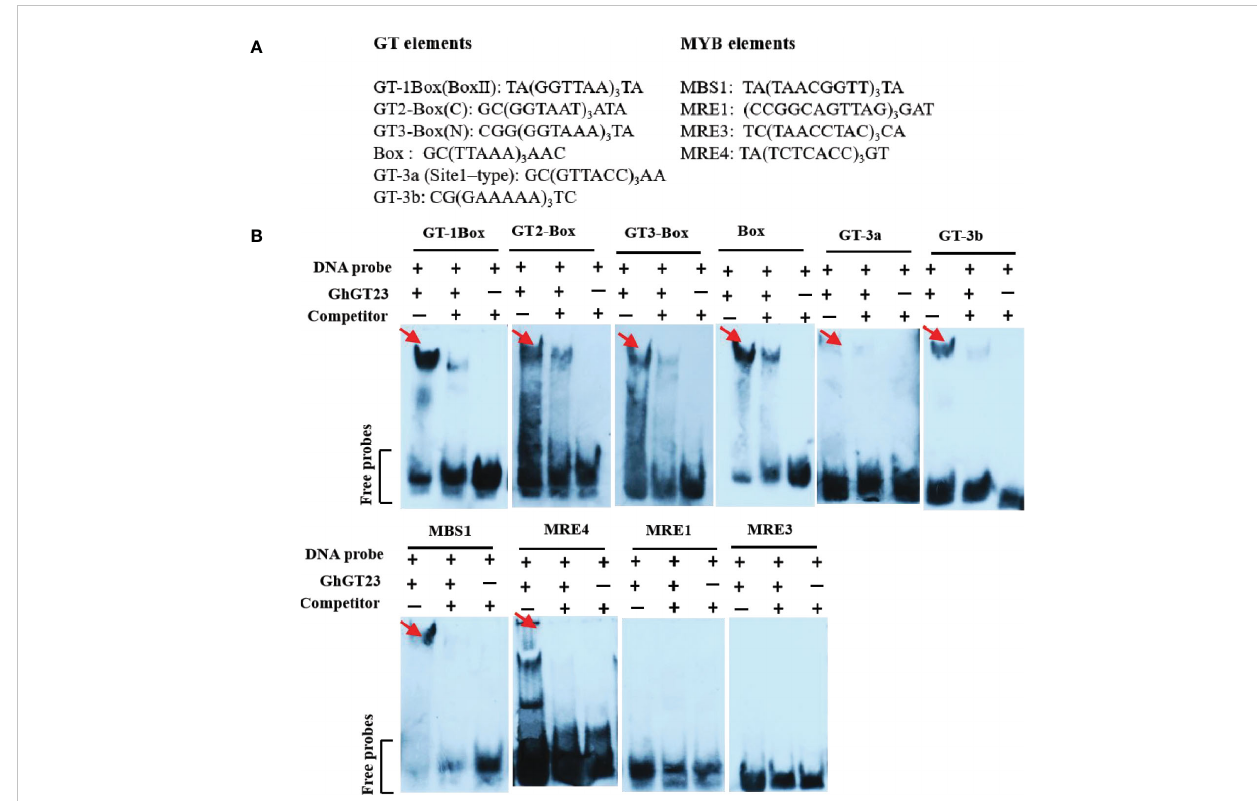
FIGURE 1 In vitro DNA-binding activity of GhGT23. (A) Sequences of the GT and MYB elements used in the electrophoretic mobility shift assay (EMSA) are shown. (B) Recombinant GhGT23 protein was incubated with the DNA probes listed in (A) in the presence or absence of a competitor. The red arrows indicate the band corresponding to the GhGT23/DNA